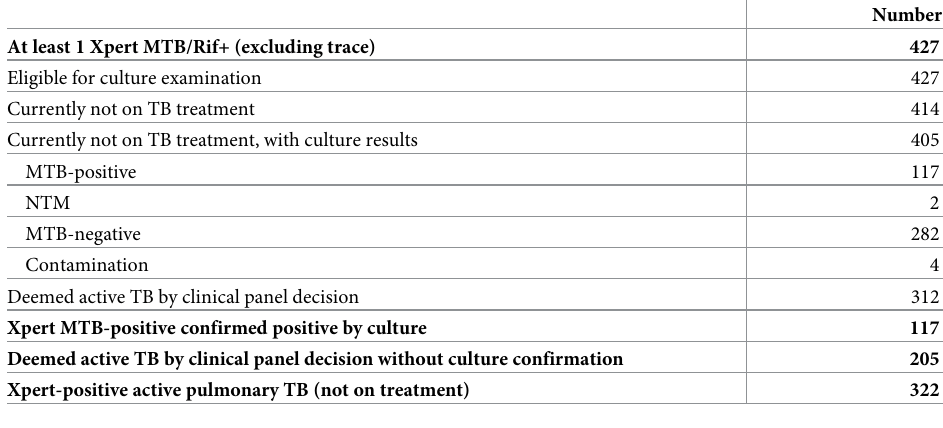
Table 2. Study TB cases after Xpert MTB, culture and clinical panel